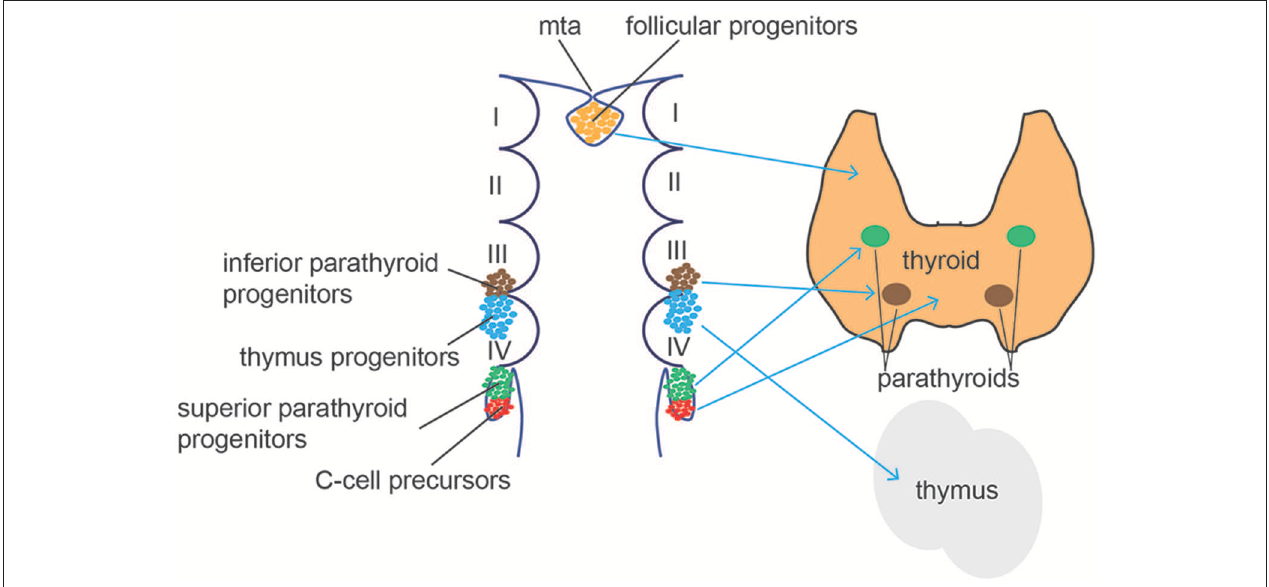
FIGURE 5 | Thyroid/Parathyroid development. Follicular thyroid progenitor cells (orange) derive from the midline thyroid anlage (mta), an endodermal tissue in the floor of the pharynx just caudal to the 1st pharyngeal arch. The superior parathyroid glands (green) originate from the 4th brachial pouch while the inferior parathyroid (blue) and the thymus develop from the 3rd brachial pouch. C cells (red) differentiate from the ultimobrachial body, below the 4th brachial